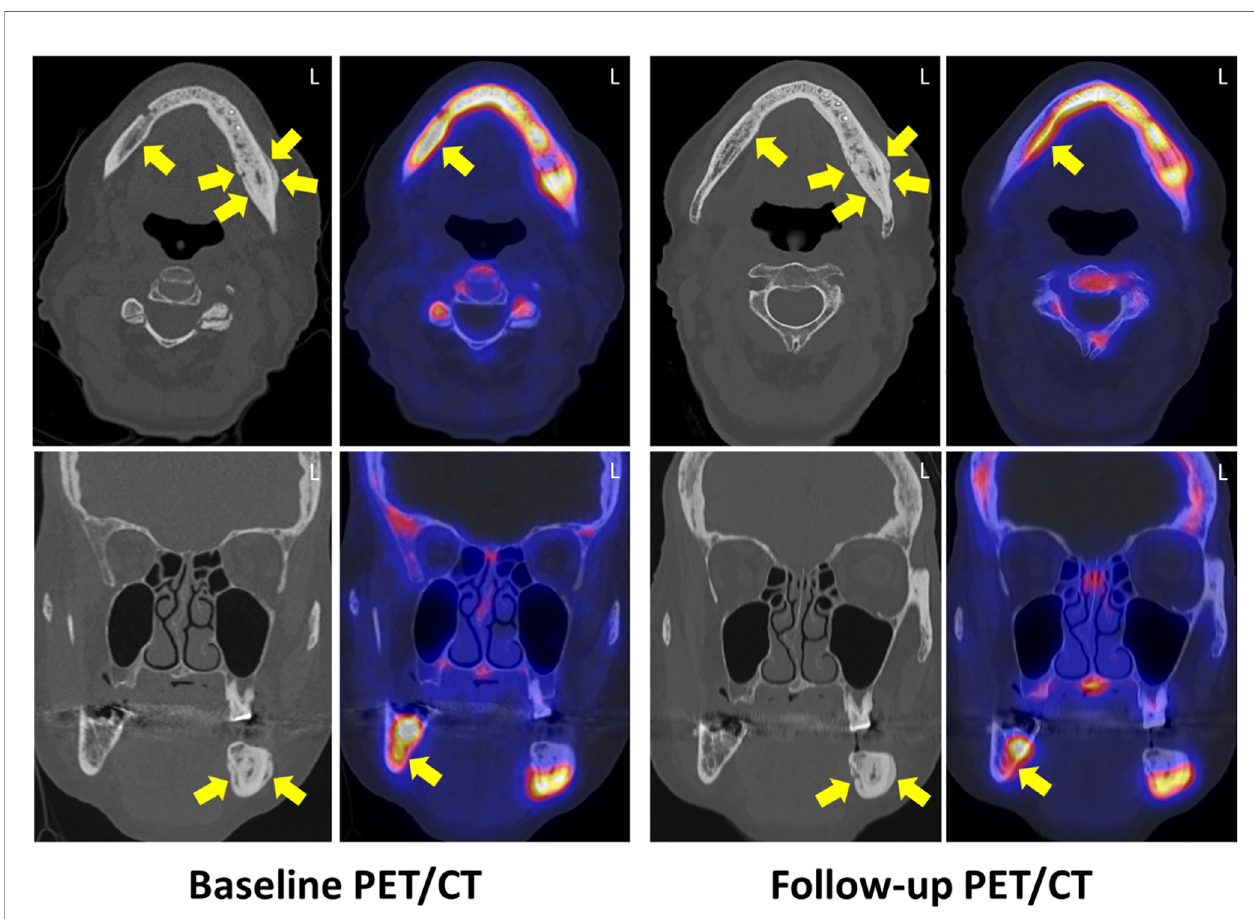
FIGURE 4 | Baseline and follow-up 18 F- fl uoride PET/CT examination 45 days after systemic antibiotic therapy. Axial (upper row) and coronal (lower row) CT reveals diffuse medullary sclerosis and a cortical thickening with con fl uent periosteal reaction (regions 37 to 42) and a focal cortical erosion (yellow arrows). The inferior alveolar canal on the left side is relatively narrowed compared to the right side. PET reveals substantially increased 18 F- fl uoride uptake in the regions 38 to 47 with a focal gap in region 36, whereas in CT, the regions 43 to 47 were only subtly sclerotic without cortical thickening. In follow-up, no changes in both CT and PET were observed in regions 38 to 42, whereas the bony sclerosis was slightly increased in regions 43 to 47 with a slight reduction of 18 F- fl uoride uptake. L, left